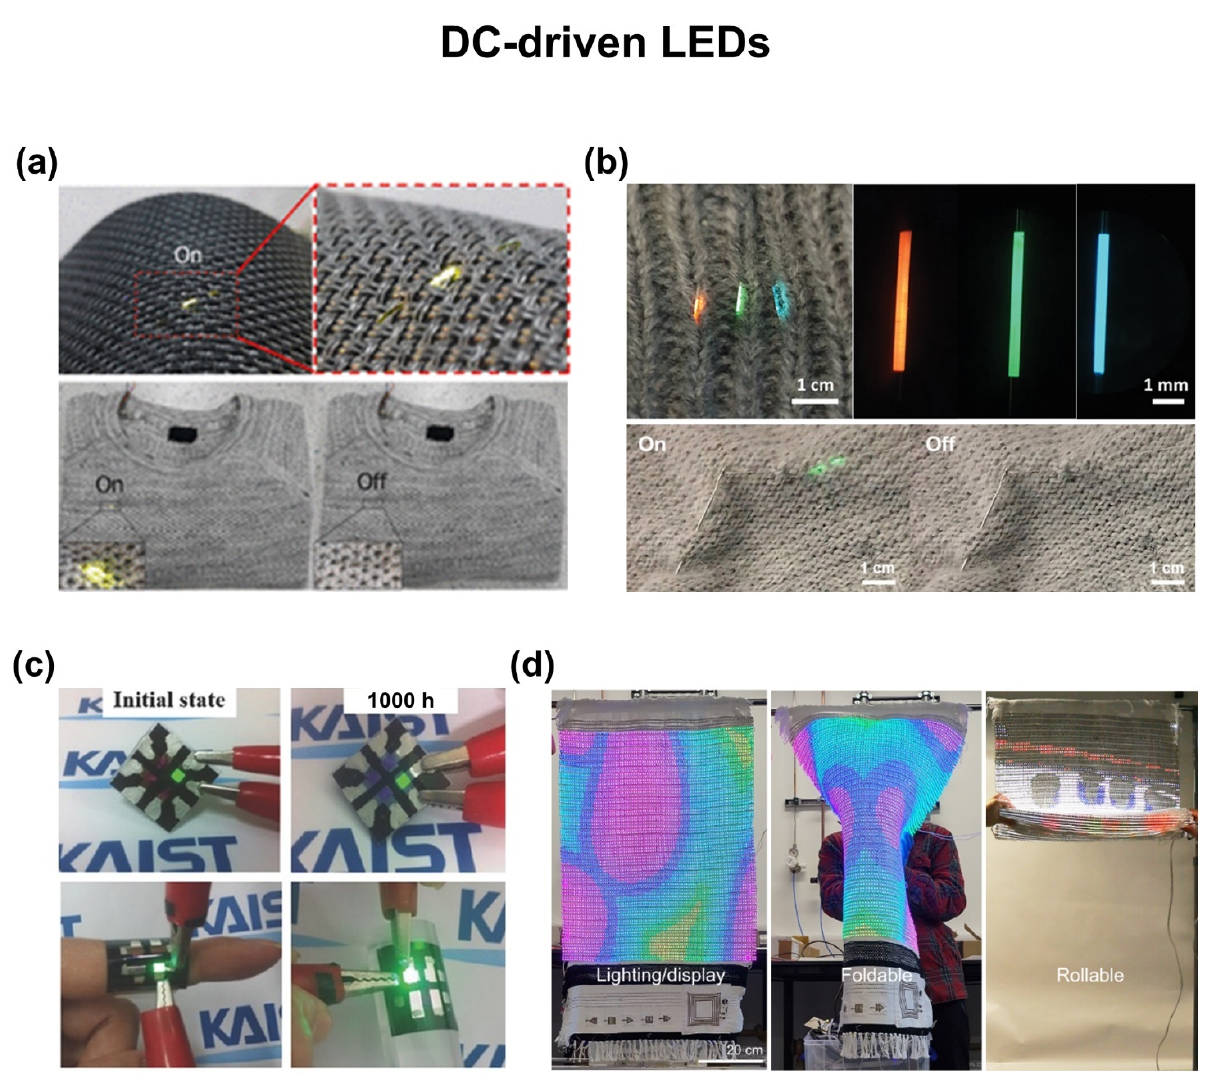
Figure 7. E-textiles for DC-driven LEDs. ( a ) Fiber-shaped OLEDs hand-woven into garments.